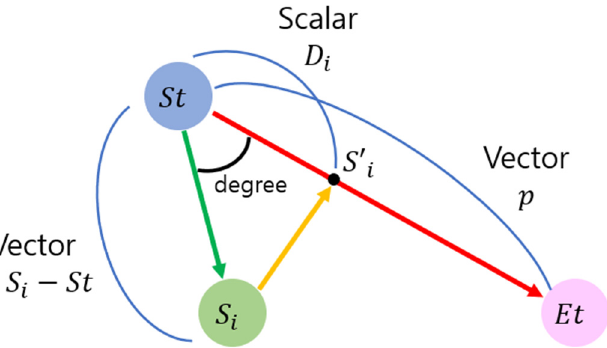
Figure 7. i -th point of the point ( S i ) set 𝑆 is projected onto the vector from 𝑆𝑡 to 𝐸𝑡 denoted as a red line. The projected points ( S ′ i ) are then sorted later.